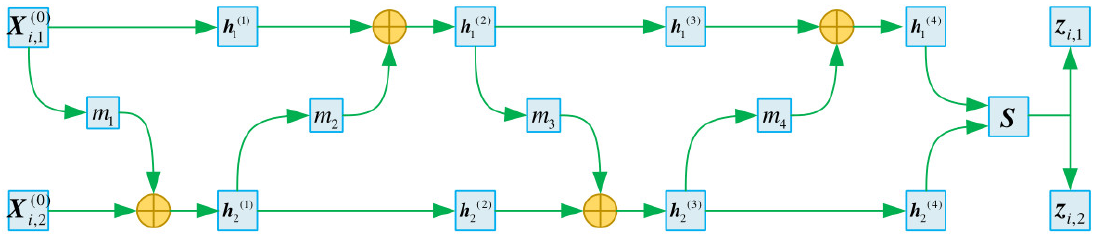
Figure 2. Structure of the NICE Model.